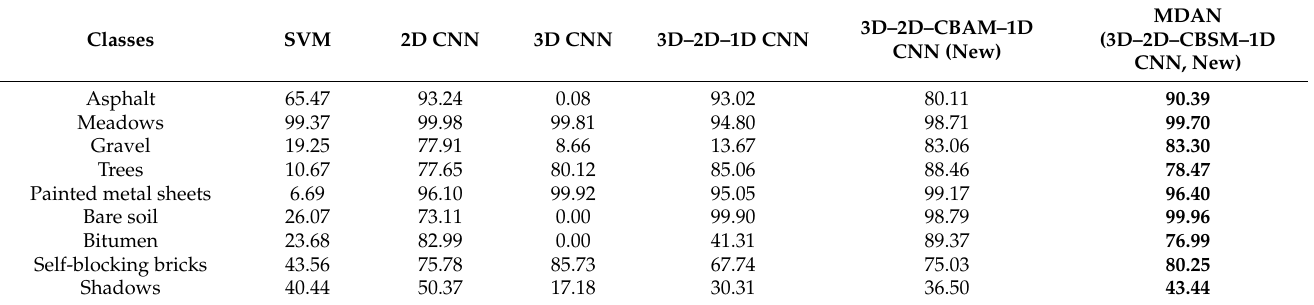
Table 8. Classification accuracies of the PU dataset. This table shows the best performances in bold.